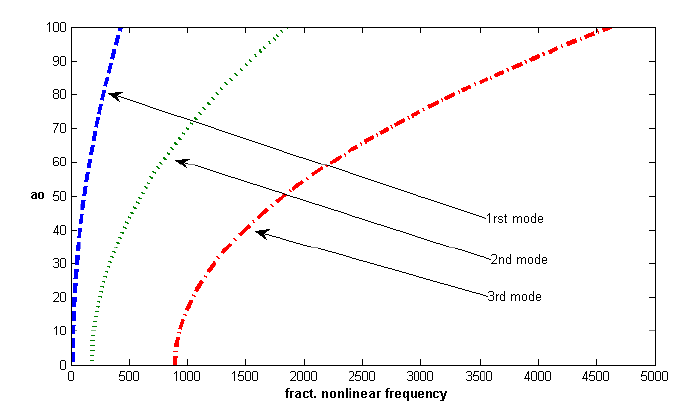
Figure 5. First three modes of the fractional nonlinear frequency versus amplitude ( α = 0.5, K = 5, Kp = 2, Cp = 0.001, η =